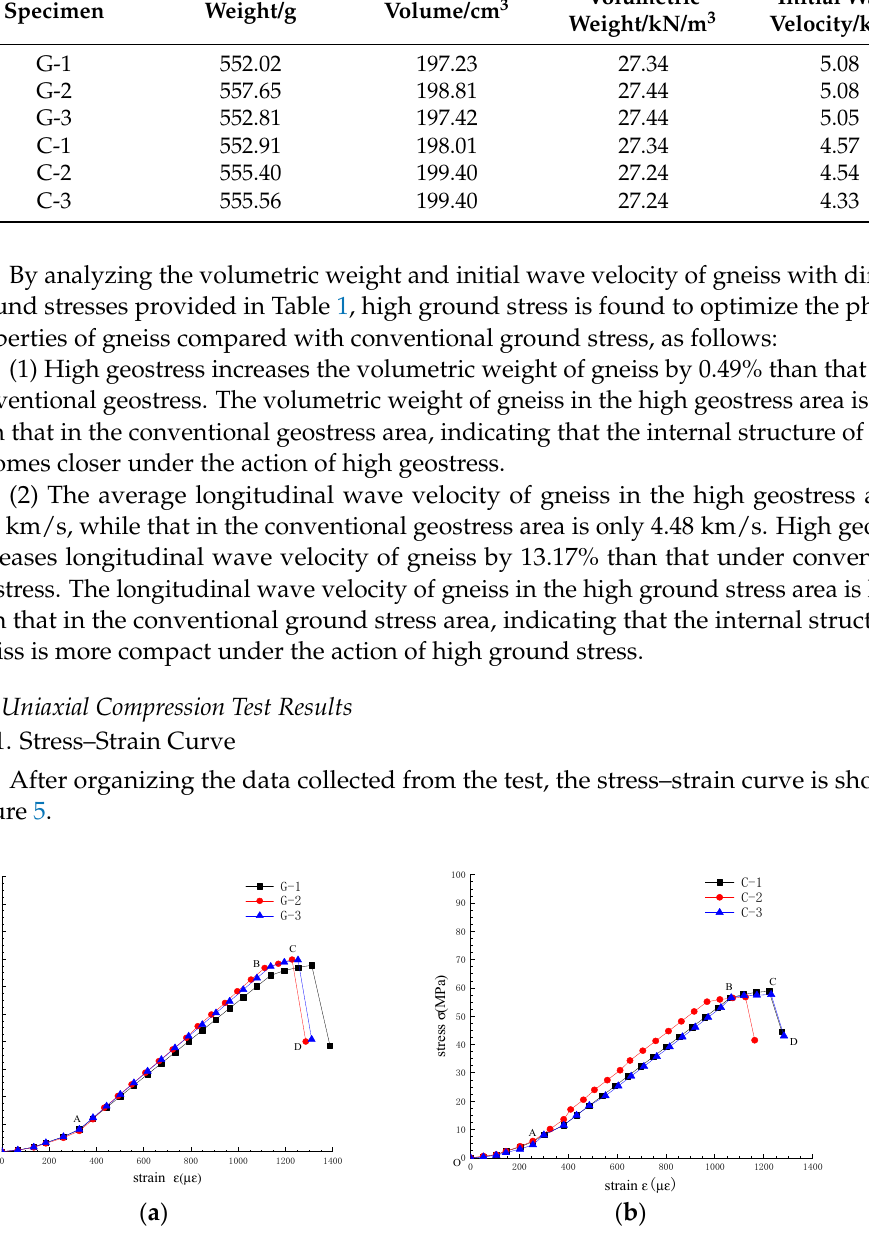
Figure 5. Stress–strain curves. ( a ) Gneiss in high geostress areas. ( b ) Gneiss in conventional geostress areas.